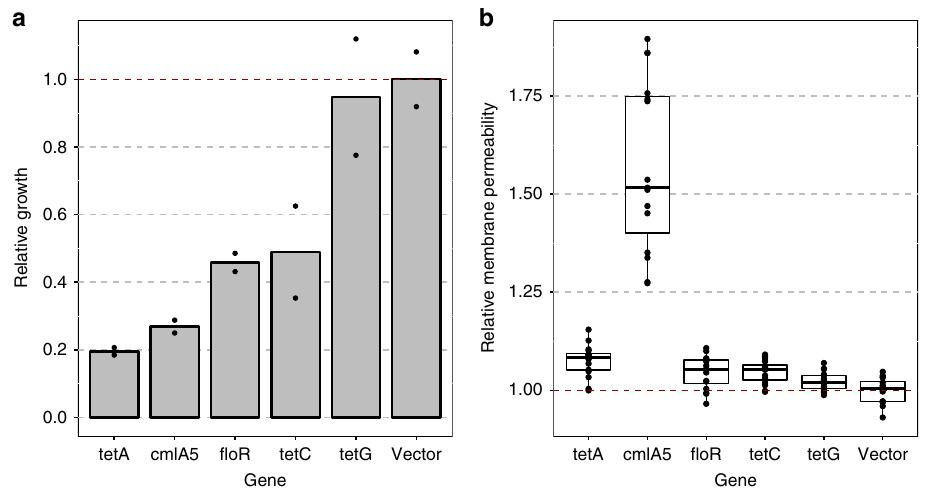
Fig. 5 Effect of different MFS ef fl ux pumps on streptomycin sensitivity and membrane permeability in the Amk4 mutant. Various genes encoding MFS pumps were independently expressed in the E. coli nuoF + fusA mutant strain. Growth ( a ) and membrane permeability ( b ) were measured and are displayed relative to those of the same E. coli strain carrying an empty vector. Membrane permeability was measured as the increase in fl uorescence resulting from Hoechst 33342 uptake. The bars show the mean of two replicates ( a ), and the boxplot the interquartile range between the fi rst and third quartiles and median (internal line) with dots representing individual fl uorescence measurements ( n = 16) ( b ). The red dashed lines indicate the values of the emty expression vector to which the remaining values are normalized. Source data are provided as a Source Data fi